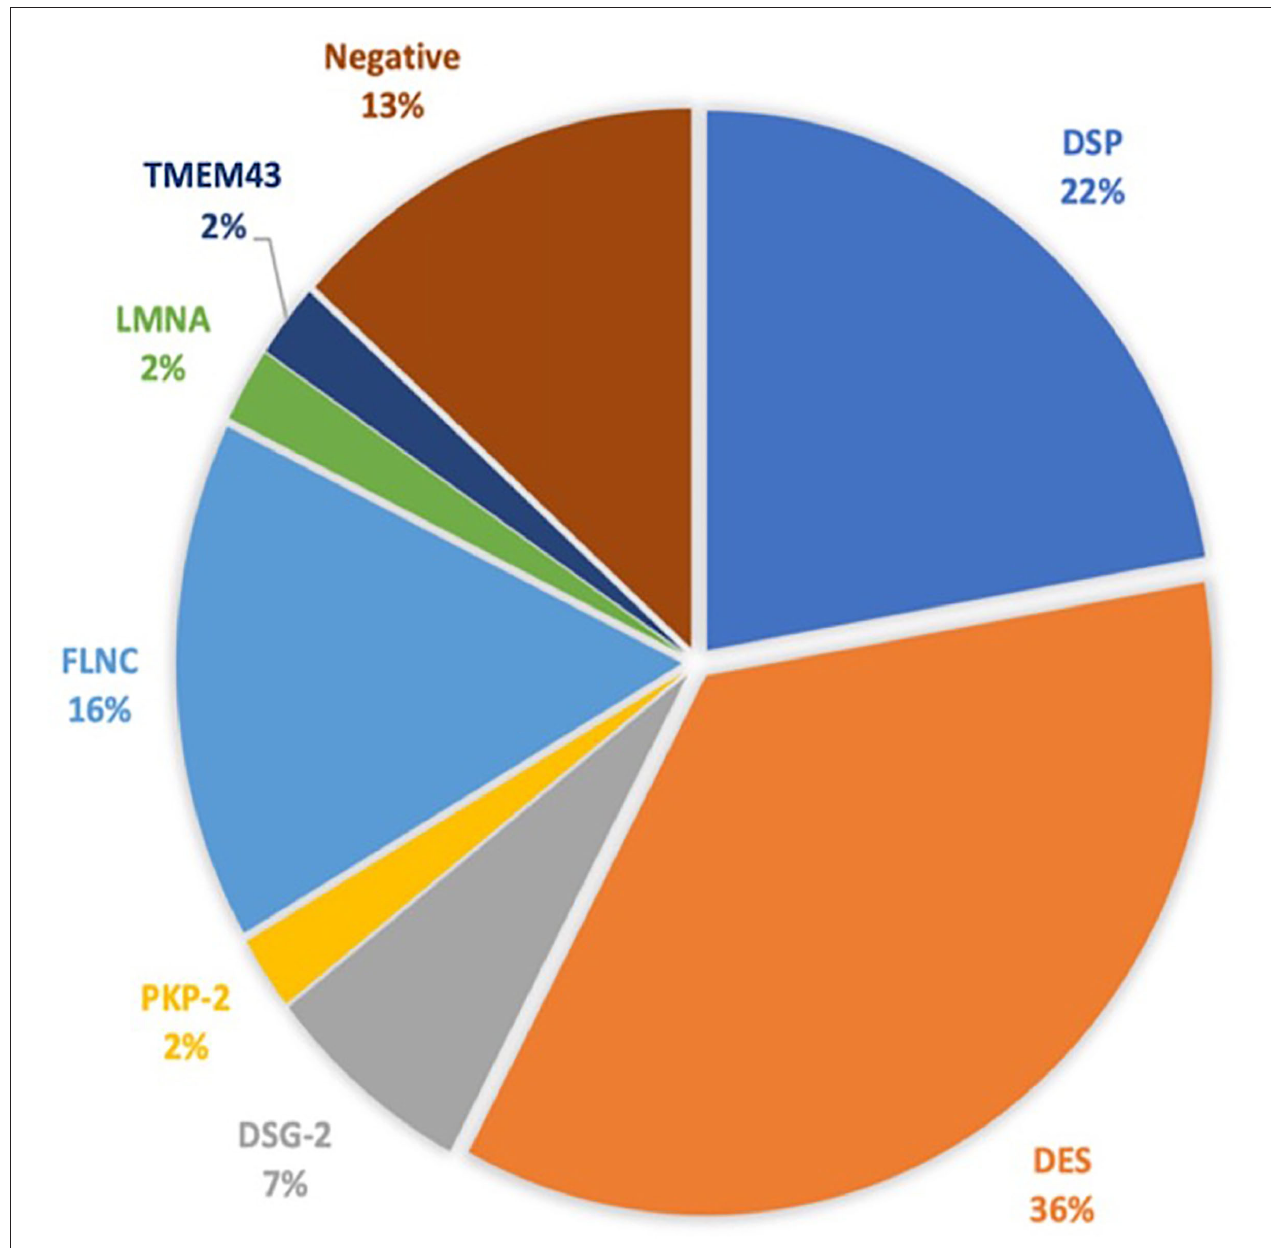
FIGURE 1 | The genetic test results. DSP, desmoplakin; DES, desmin; DSG-2, desmoglein-2; PKP-2, plakophilin; FLNC, filamin C; LMNA, lamin A/C; TMEM43, transmembrane protein 43.